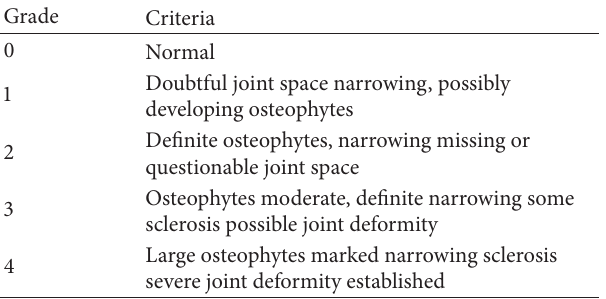
Table 1: The radiographic parameters for knee OA